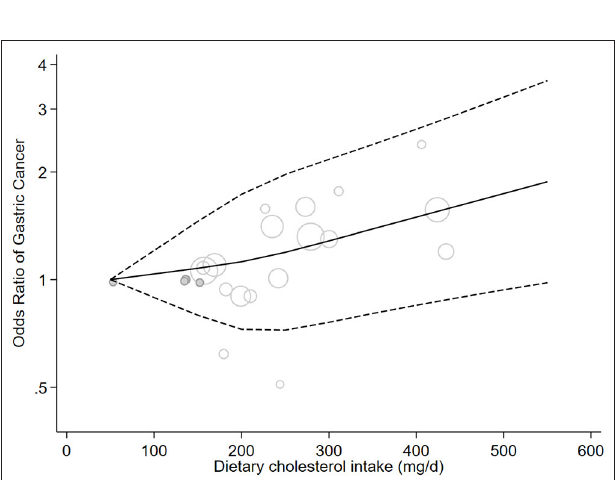
FIGURE 4 | Non-linear dose-response meta-analysis of case-control studies investigating the association between cholesterol consumption and risk of gastric cancer in adults ( P =